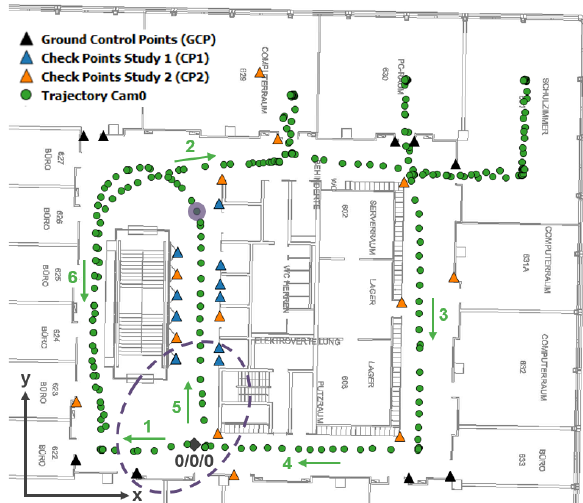
Figure 8. Floor base map with overlaid projection centers of camera head cam0, ground control points, check points,